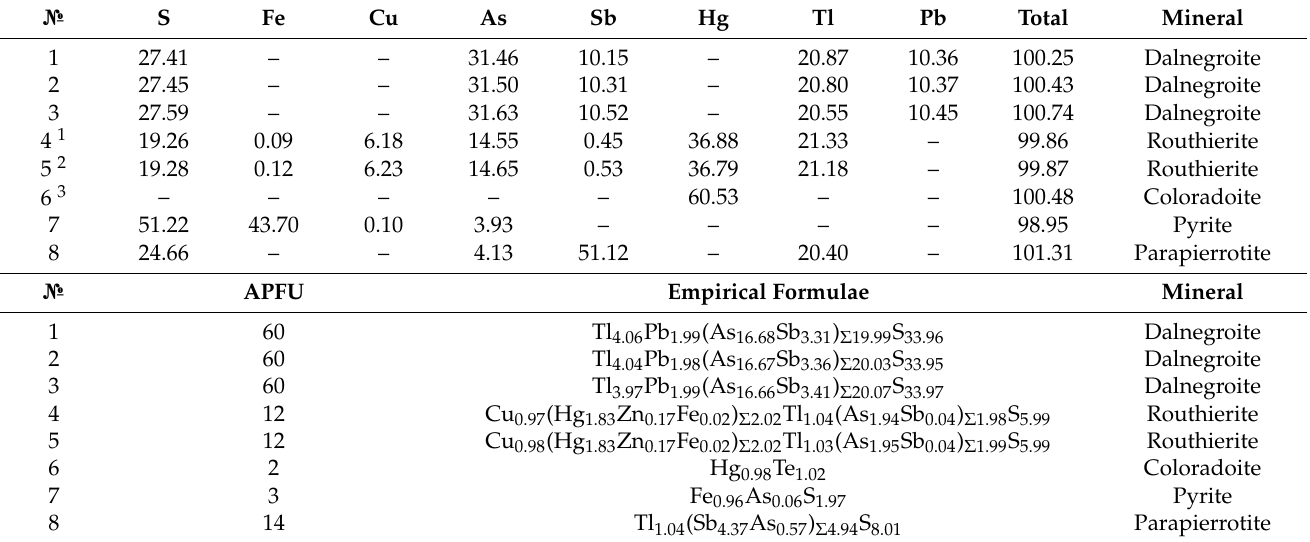
Figure 8. BSE-photo of the morphology of native gold grains and aggregates from breccias with orpiment-realgar cement (explained in the text). ( a ) gold crystal; ( b ) gold with mineral inclusions of calcite (Cal), pyrite (Py) and realgar (Rlg); ( c ) native gold intergrows with pyrite; ( d ) native gold intergrows with realgar; ( e ) native gold intergrows with calcite; ( f ) pyrite crystals in native gold. Table 2. The chemical composition of minerals intergrown with native gold, wt.